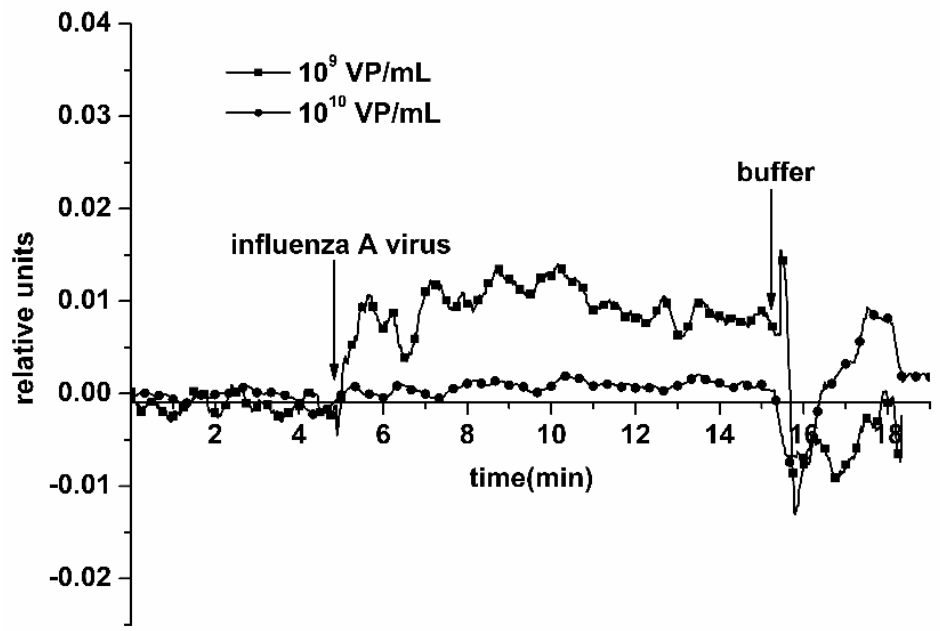
Figure 6. Typical sensograms obtained upon the detection of influenza A virus with the use of the NR detector. Experimental conditions: 1 mM potassium phosphate buffer, pH 7.4, V g 55 V, V ds 0.1 V, solution volume in the cell 107 µ L; NR is sensitized with antibodies against influenza virus. Concen- tration of viral particles in the analyzed solution is 10 9 VP/mL (squares) and 10 10 VP/mL (circles). Arrows indicate addition of the sample solution and washing with pure potassium phosphate buffer.